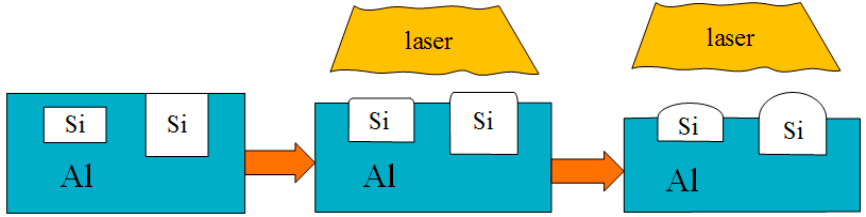
Figure 7. Laser finishing process of the Al–Si alloy cylinder liner.